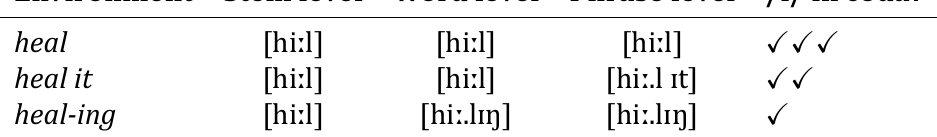
Table 2: Number of cycles meeting the conditions for darkening